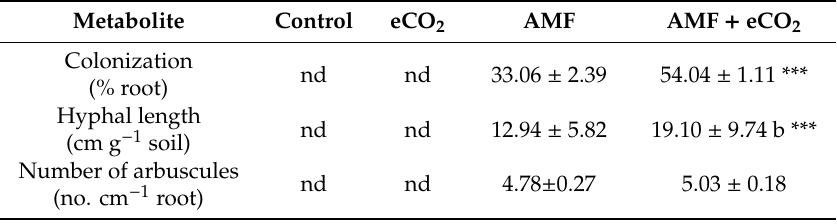
Table 1. Mycorrhizal colonization and growth parameters in roots of Thymus vulgare grown under normal conditions (control) or the e ff ect of eCO 2 (620 ppm), arbuscular mycorrhizal fungi (AMF) or their combination (AMF-eCO 2 ). Values are mean ± standard error of five independent replicates. Asterisks indicate significant changes (*** p < 0.001) between AMF alone and the combined AMF + eCO 2